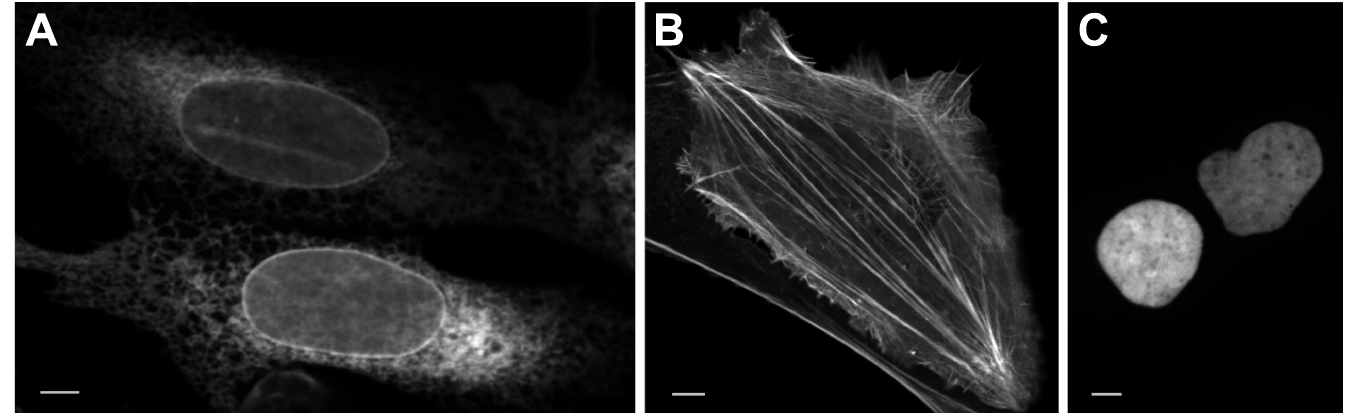
Fig 4. Expression of mAvicFP1-tagged proteins in mammalian cells. mAvicFP1 fusions to (A) CytERM, (B) LifeAct, and (C) H2B. U2-OS cells display expected localization. Scale bar is 10 mm. The data underlying this figure (raw image data) may be found at https://doi.org/10.26300/4x48-y393.